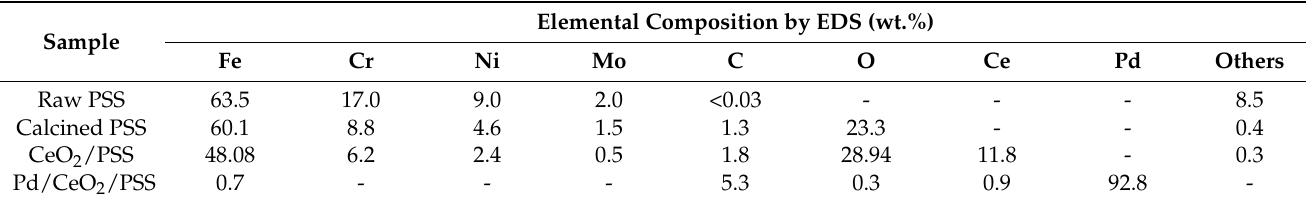
Table 1. Membrane elemental composition that was found using EDS at diverse stages of the fabrication process. Elemental Composition by EDS Sample